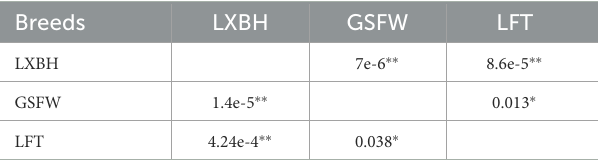
Results below the diagonal line represent the Chi-square test of genotype frequency for each sheep breed; Results above the diagonal line represent the Chi-square test of allele frequency foreachsheepbreed. ∗ P < 0.05, ∗∗ P < 0.01.